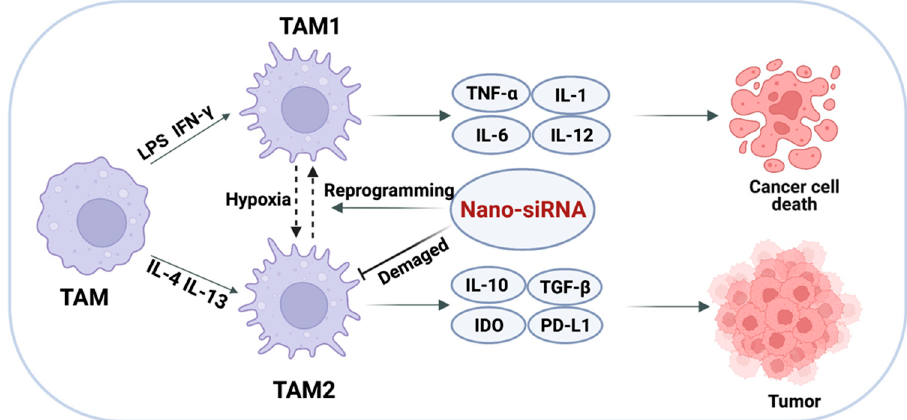
Figure 5. Targeted delivery of siRNA to TAMs. Altering the polarization of TAMs or impairing the survival and function of TAMs to achieve the elimination of immune evasion.